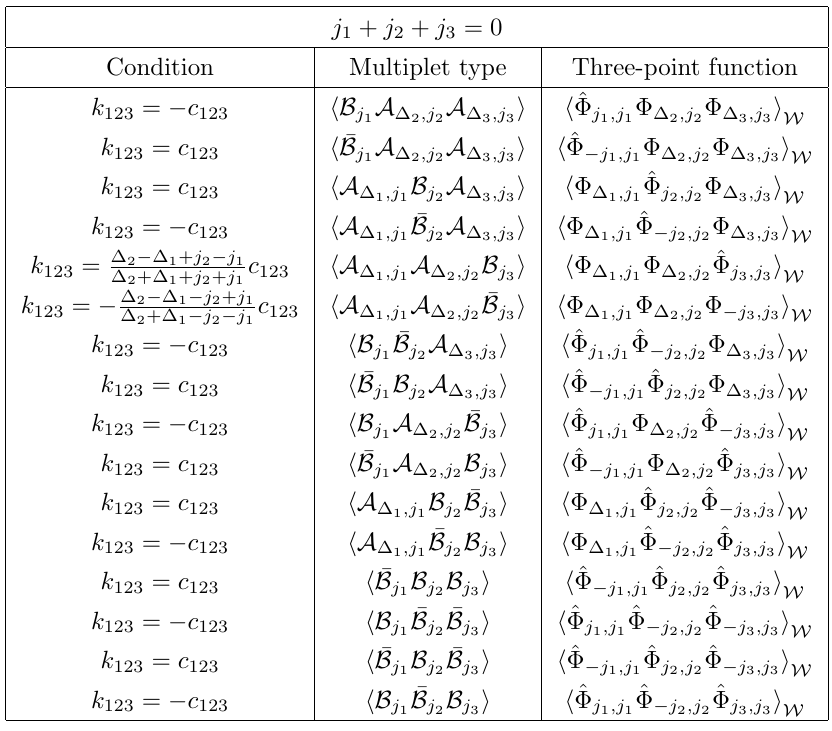
Table 1 . Non-vanishing three-point functions of super(cid:12)elds with j 1 + j 2 + j 3 = 0.